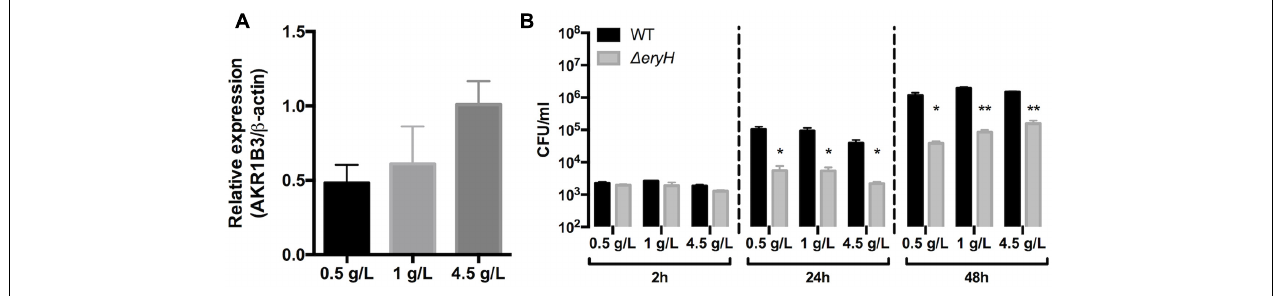
FIGURE 6 | The expression of Aldose reductase gene Akr1b3 in RAW 264.7 macrophages depends on glucose concentration. (A) Expression of gene Akr1b3 measured by qRTPCR in macrophages cultured with 0.5, 1, and 4.5 g/L of glucose. (B) Multiplication of B. abortus 2308 WT and (cid:49) eryH in macrophages cultured with 0.5, 1, and 4.5 g/L of glucose. All experiments were performed in biological and technical duplicates ( ∗ p < 0.05; ∗∗ p < 0.01; ∗∗∗ p < 0.001 [Student’s t -test]).